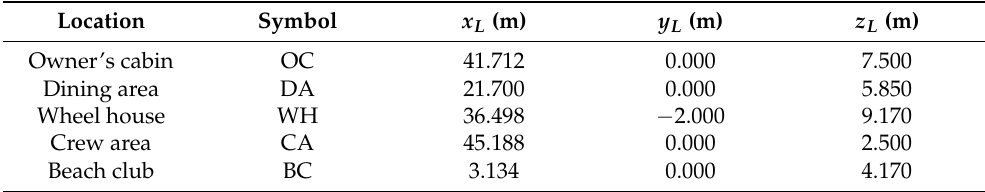
Table 4. Coordinates of the AWI 22834 locations on the reference hulls * .